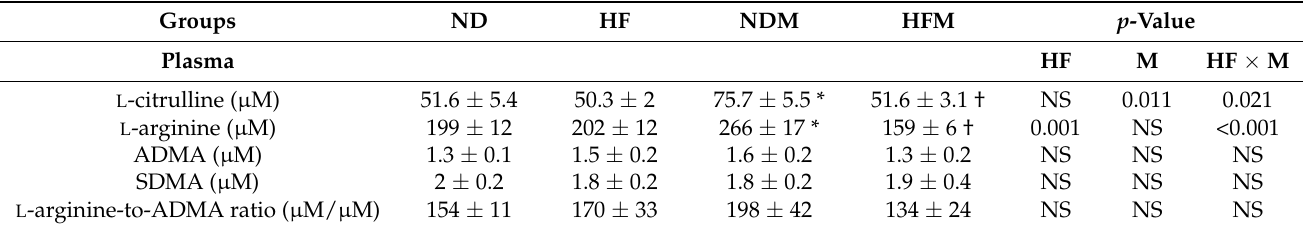
Table 3. Nitric oxide (NO)-related